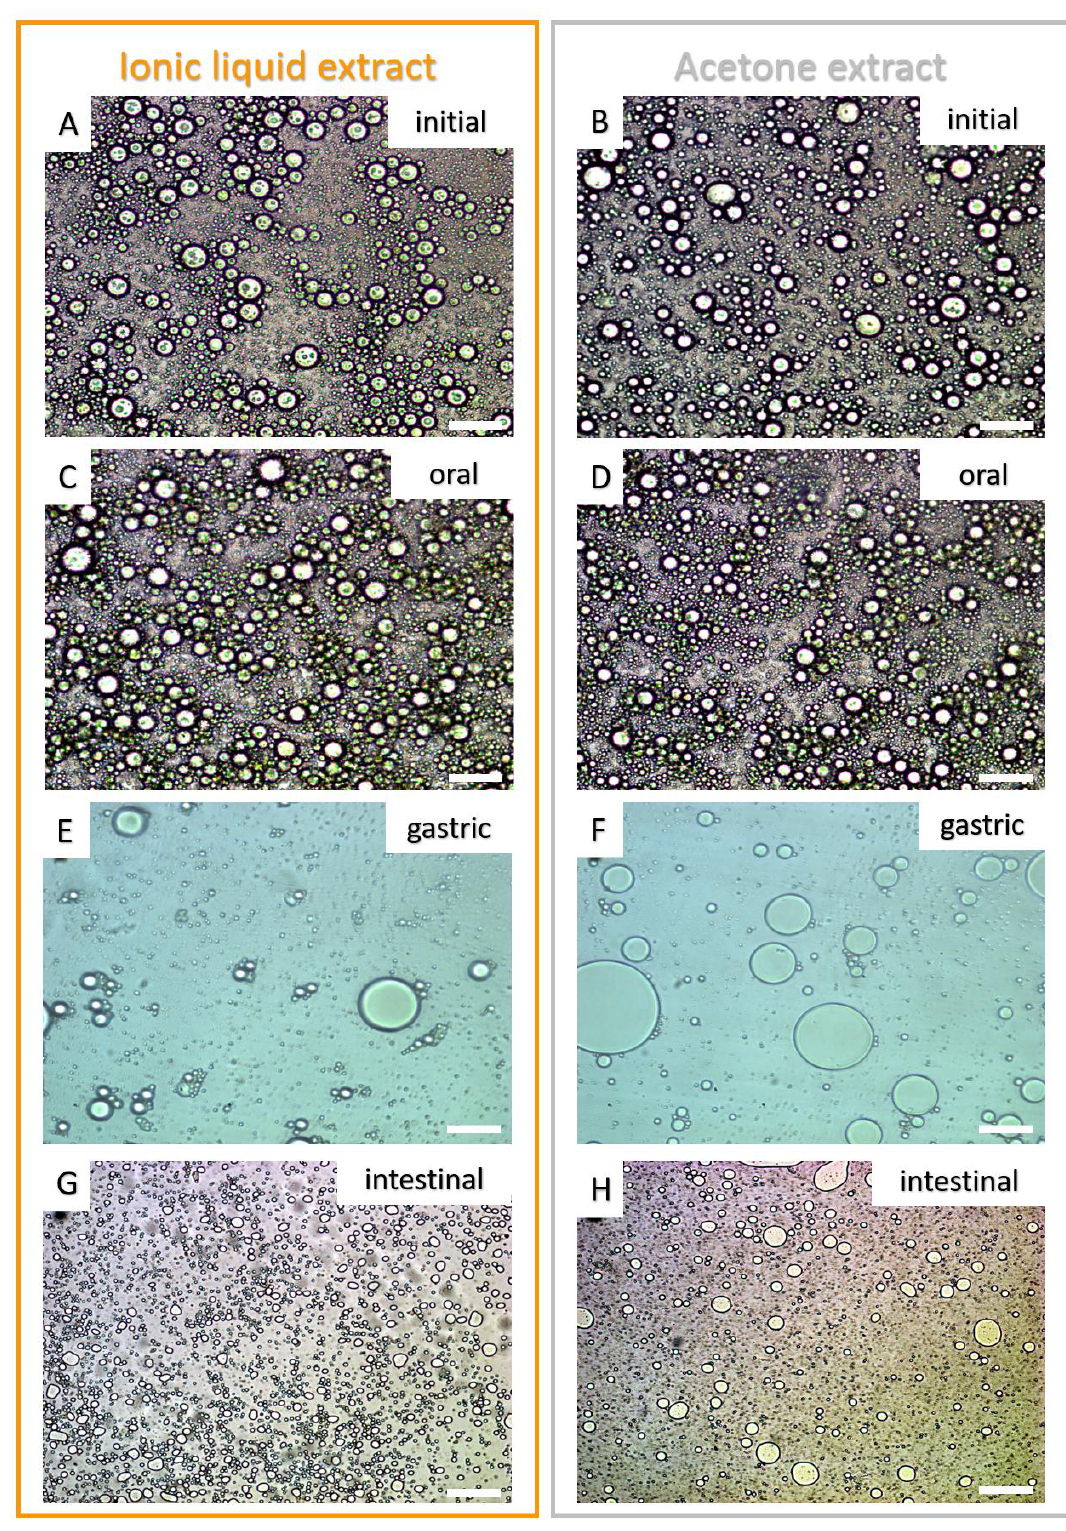
Figure 4. Micrographs of the initial emulsions ( A , B ) and after the simulated digestion process (oral—( C , D ), gastric—( E , F ), and intestinal phases—( G , H )). White scale bars represent 20 µm.